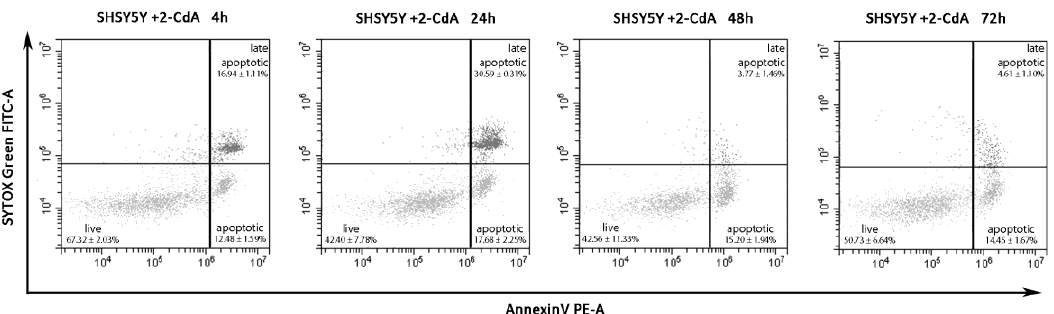
Figure 4. Representative dot plots of annexin V / SYTOX Green assay on SH-SY5Y cells exposed to 20 nM 2-CdA for 4, 24, 48, and 72 h. The population, gated on not treated events (control, not shown in dot plots) was divided into live events ( lower left ), apoptotic events ( lower right ), and late apoptotic events ( upper right ). The percentage of apoptotic events ( lower right ) was similar among the four time points analyzed: 12.48 ± 1.59% at 4 h; 17.68 ± 2.25% at 24 h; 15.20 ± 1.94% at 48 h; 14.45 ± 1.67% at 72 h (data are expressed in mean of percentage ± SD; n = 4).